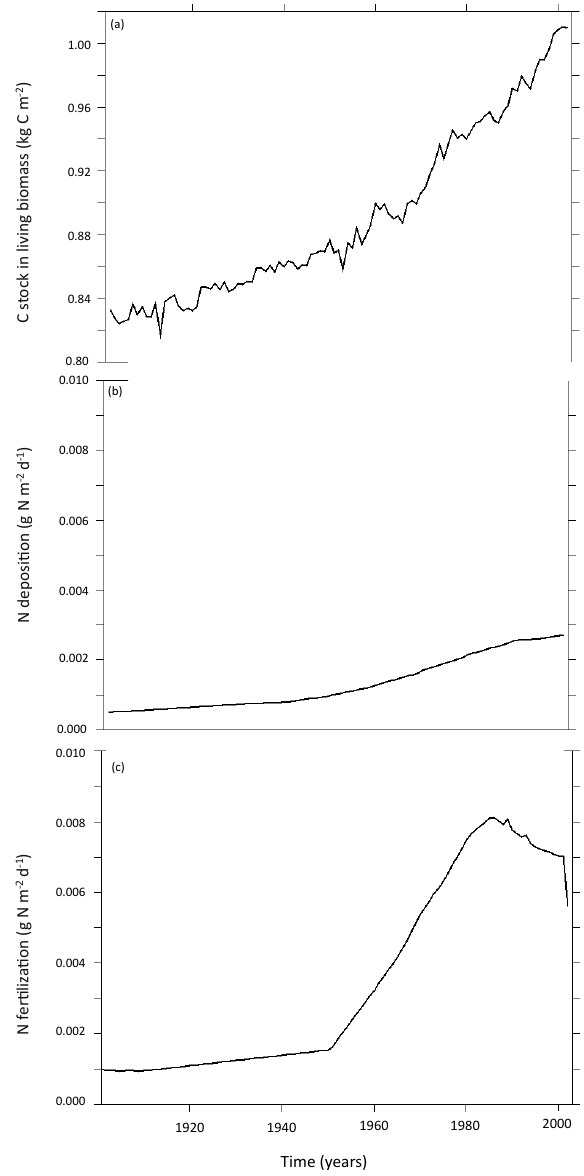
Fig. 3. Evolution over the 20th century of C stored in living biomass (a) , of N deposition (b) and of N fertilization (c) in O-CN (annual